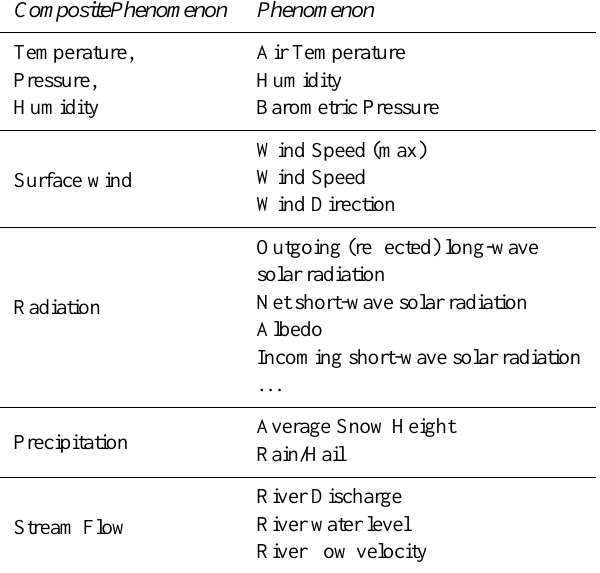
Table 4. CompositePhenomenon defined by combining SOPAF- Phenomenon . The SOS construct of CompositePhenomenon (SOS, 2007) gives users a more convenient access to observed quantities, which are physically closely related. The table shows only a sub- set of defined CompositePhenomenon , the full set is available by methods described in Sect. 3.2.